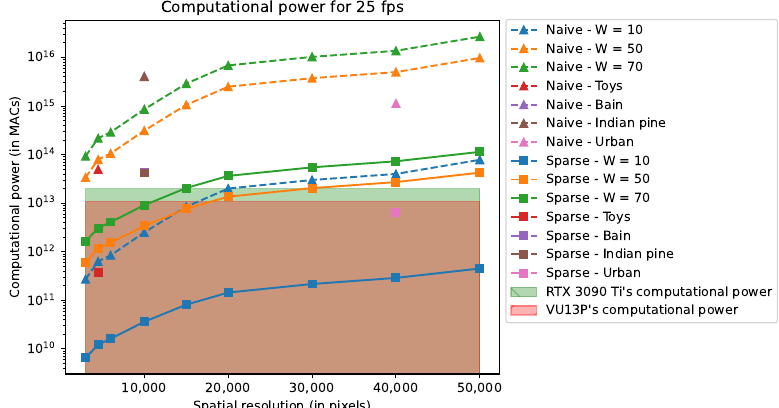
Figure 10. Computational power for 25-fps related to the RTX 3090 Ti and VU13P rated performances using the OR model.